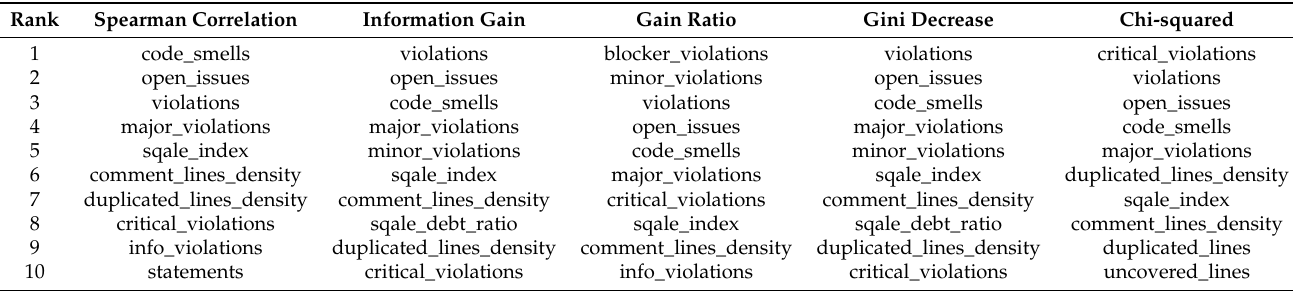
Table 3. Ten best features obtained for different ranking